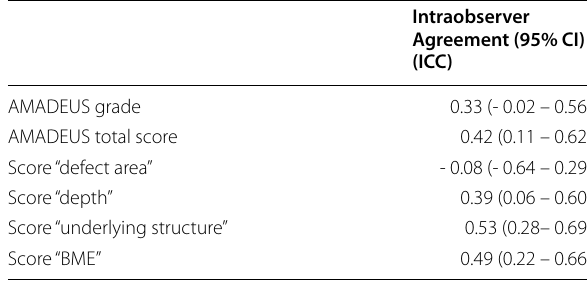
Table 3 Intraclass correlation coefficients for